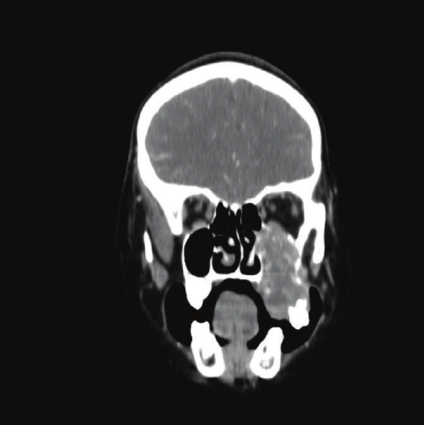
Figure 6: Coronal section of CT scan showing extent of tumor.